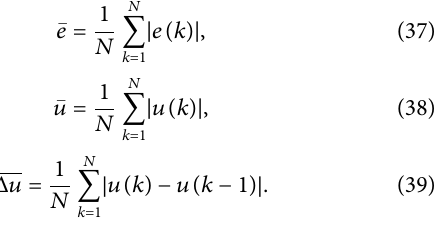
Frontiers in Robotics and AI |